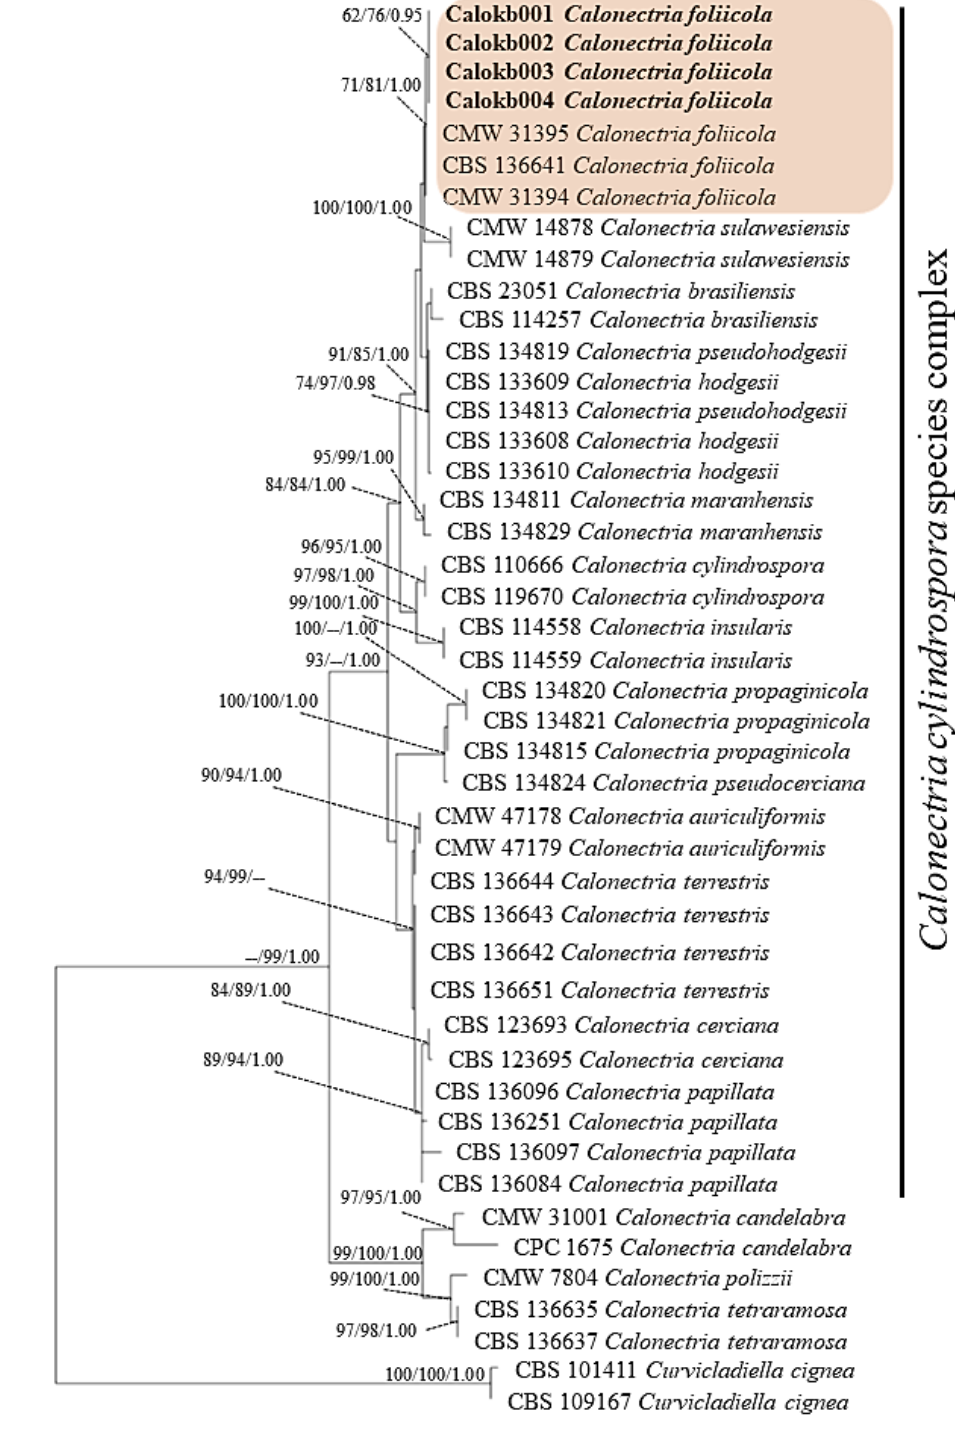
Figure 3. Phylogenetic tree generated from maximum likelihood (ML) and based on the combined sequences of ITS, tub2, cal , and tef1- α sequence data of Calonectria spp. in the C. cylindrospora species complex. Bootstrap values for maximum likelihood (ML) and maximum parsimony (MP) equal to or greater than 50% and Bayesian posterior probabilities (BYPP) equal or greater than 0.95 are indicated. The isolates obtained in this study are indicated in bold. The tree is rooted to Curvicladiella cignea .